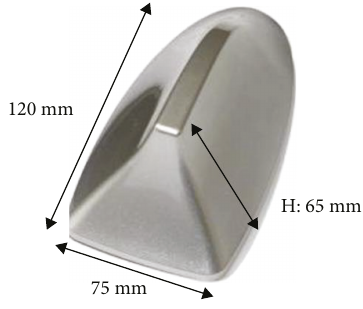
Figure 1: Dedicated space of automotive antenna.